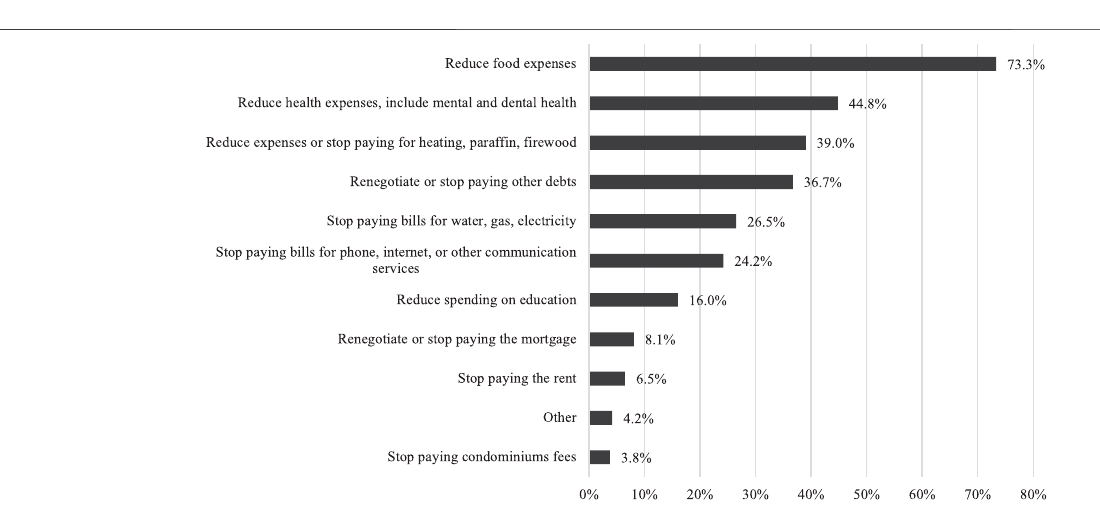
Frontiers in Sociology |